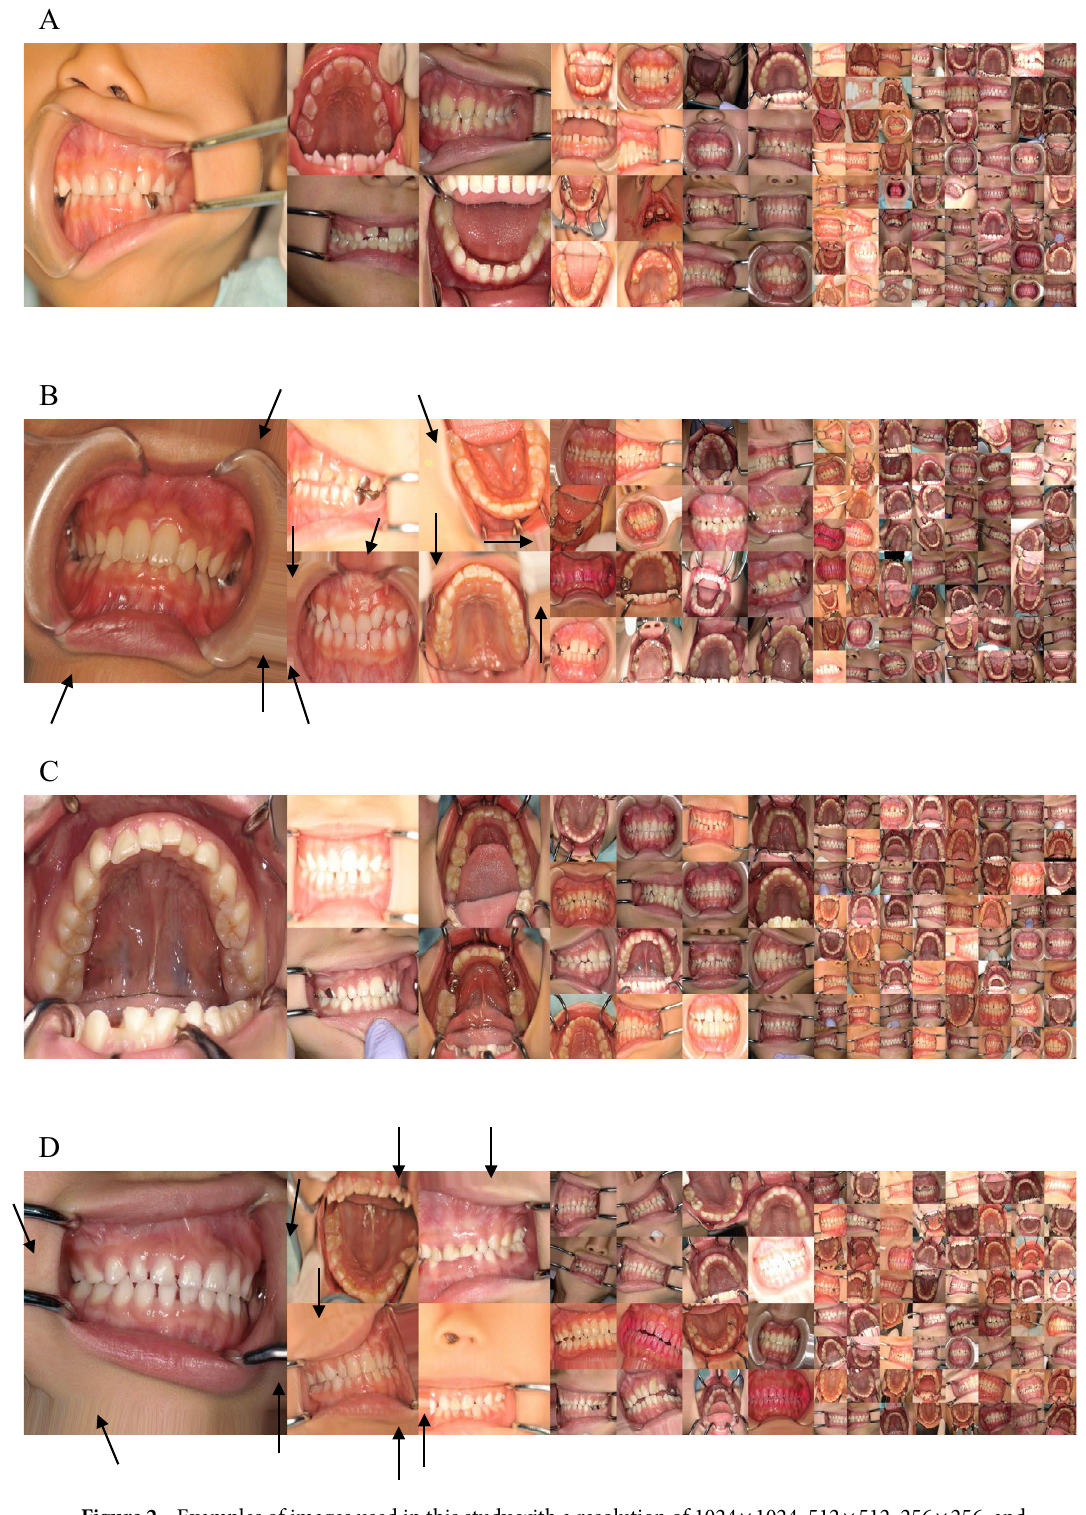
Figure 2. Examples of images used in this study with a resolution of 1024 × 1024, 512 × 512, 256 × 256, and 128 × 128. Arrows indicate the examples where the boundaries of the training images with data augmentation are filled with the closest pixel value and repeated for all the empty values, which is the effect of the fill_mode of ImageDataGenerator. ( A ) Real images used for training without data augmentation. ( B ) Real images used for training with data augmentation. ( C ) Generated images trained with real images that were not augmented. ( D ) Generated images trained with real images that were